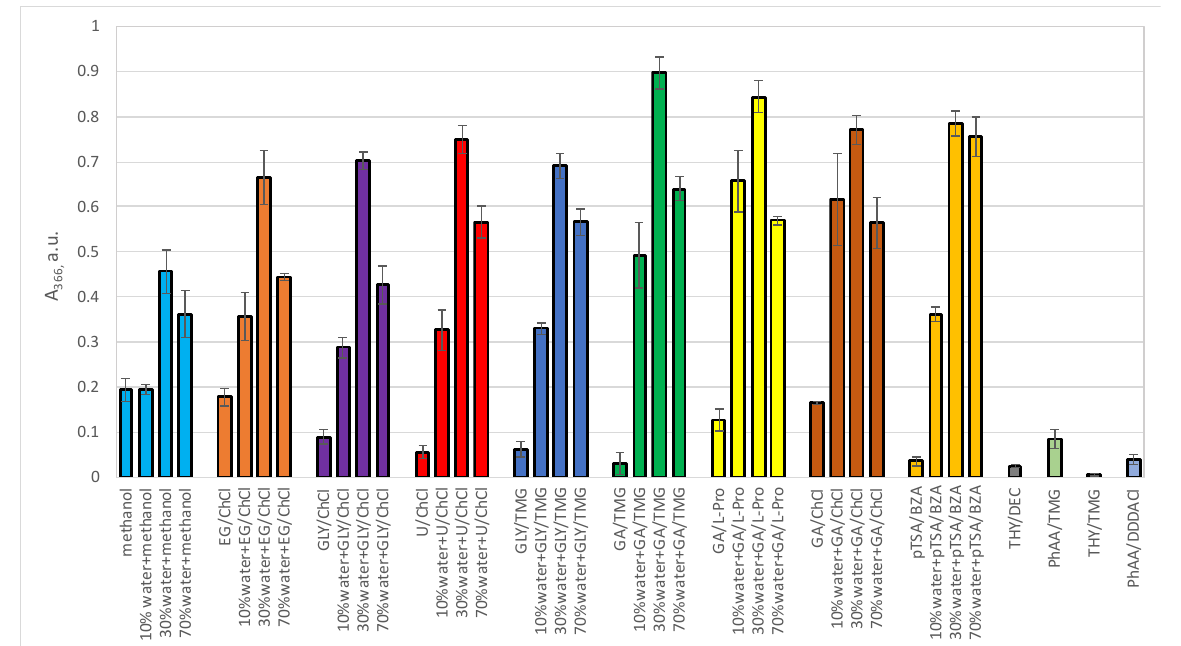
Figure 1. UV-Vis Absorbance at λ = 366 nm of the supernatants of the extraction of onion skin diluted in ethanol (50 µL in 2 mL EtOH). Extraction conditions: 50 mg of onion skin in 1.5 g of aqueous DES, heating and stirring (50 °C, 300 rpm) for 30 min then 45 min of sonication in bath followed by centrifugation of the extracts for 30 min at 7000 rpm. EG/ChCl 2/1 molar ratio; GLY/ChCl 2/1 molar ratio; U/ChCl 2/1 molar ratio; Gly/TMG 3/1 molar ratio; GA/TMG 2/1 molar ratio; GA/L-Pro 3/1 molar ratio; GA/ChCl 2/1 molar ratio; pTSA/BZA 1/1 molar ratio; THY/DEC 2/1 molar ratio; PhAA/TMG 2/1 molar ratio; THY/TMG 3/1 molar ratio; PhAA/DDDACl 2/1 molar ratio. Water amounts are considered as added water to the starting DESs (initial water amounts spanning from 0.1% to 5% w / w ).